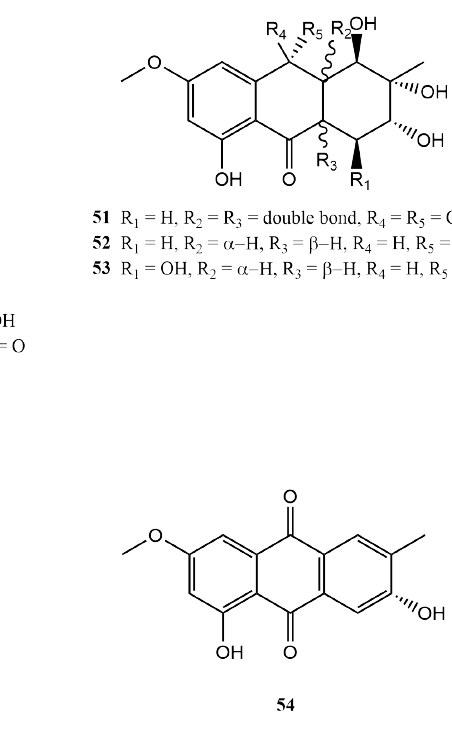
Figure 4. The chemical structures of compounds 44 – 54 . Subsequently, several bianthraquinones were isolated from the soft-coral-derived marine fungi as well. Alterporriol C ( 55 ) belongs to a modified bianthraquinone and was first isolated from the fungus Alternaria porri as red needles [93]. Alterporriol C ( 55 ), which was antibacterial against Escherichia coli and Vibrio parahemolyticus with both MIC values 2.5 μ M, is suggested to be made up of the compounds altersolanol A and macrosporin ( 54 ) [49]. Alterporriol N ( 56 ) was an amorphous powder in red. 13 C NMR spectrum analysis suggested that alterporriol N ( 56 ) was a symmetrical dimer of altersolanol C ( 51 ) with a C-8 and C-8 (cid:48) linkage [49]. Another symmetrical dimer to altersolanol C ( 51 ) isolated from Alternaria sp. was alterporriol O ( 57 ), which appeared as a red amorphous powder. Unlike alterporriol N ( 56 ), alterporriol O ( 57 ) was an anthranoid dimer with a C-4 and C4’ linkage [49]. Likewise, alterporriol P ( 58 ) was also a red, amorphous powder, with the molecular formula of C 32 H 26 O 12 . Alterporriol P ( 58 ), also isolated as a red amorphous powder, was characterised as a sub-unit of the altersolanol C ( 51 ) and macrosporin ( 54 ) linkage via carbon C-4 and C-6’. This compound was cytotoxic against the human prostate cancer (PC-3) and human colorectal carcinoma (HCT-116) cell lines with the IC 50 values 6.4 and 8.6 μ M [49]. In contrast, alterporriol Q ( 59 ) was obtained as a yellowish amorphous powder, and the final anthraquinone characterised from Alternaria sp. was alterporriol R ( 60 ), which was determined to be an isomer of alterporriol Q 59 [49]. These compounds were comprised of two macrosporin ( 54 ) sub-units. The two sub-units of alterporriol Q ( 59 ) were linked through carbons C-4 and C-6’, while alterporriol R ( 60 ) was connected via carbons C-4 and C-8 (cid:48) . Alterporriol Q ( 59 ) exhibited antiviral activity against the porcine reproductive and respiratory syndrome virus (PRRSV), with an IC 50 value of 39 μ M